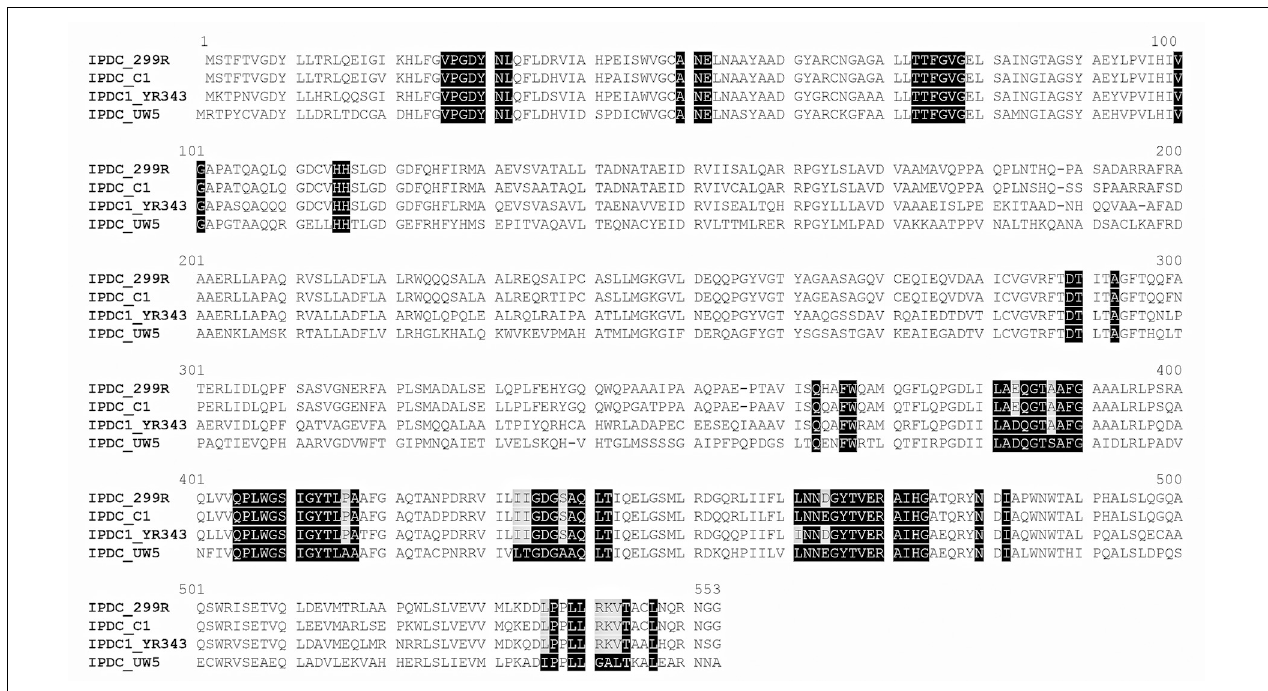
FIGURE 2 | Sequence alignment of peg.1955 encoded protein from P. agglomerans strain C1 and functionally characterized IPDC from E. ludwigii and other Pantoea strains. Residues in IPDC sequence from E. ludwigii UW5 that have been identified by crystal structure analysis as being at the active site or involved in either ThDP or substrate binding are highlighted in black. In the alignment, the amino acid residues of these regions that are conserved among all or almost all different sequences are highlighted in black or gray.